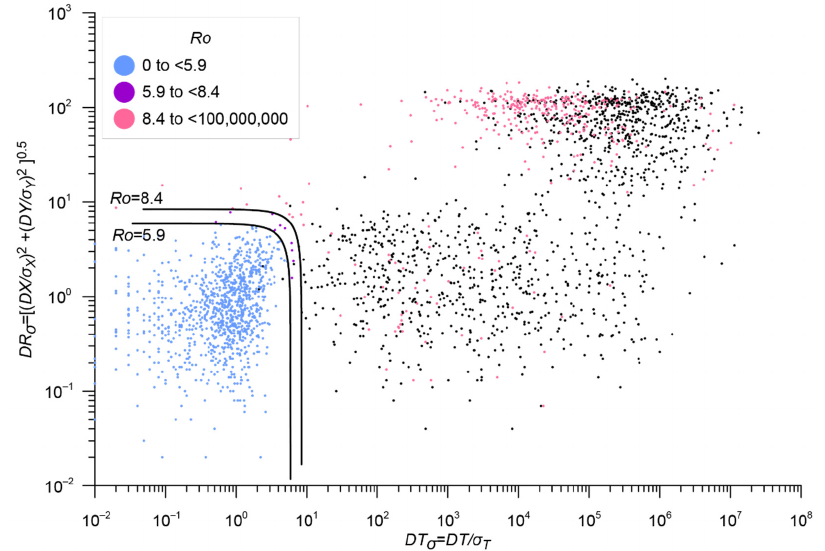
Figure 12. Distribution of normalized DT and DR and metric level lines (1). The colored dots are the CORE/RUS_ISC pairs and the black dots are the distances between the CORE/CORE events in metric (1). The metric levels Ro = 5.9 and Ro = 8.4 are shown by lines.